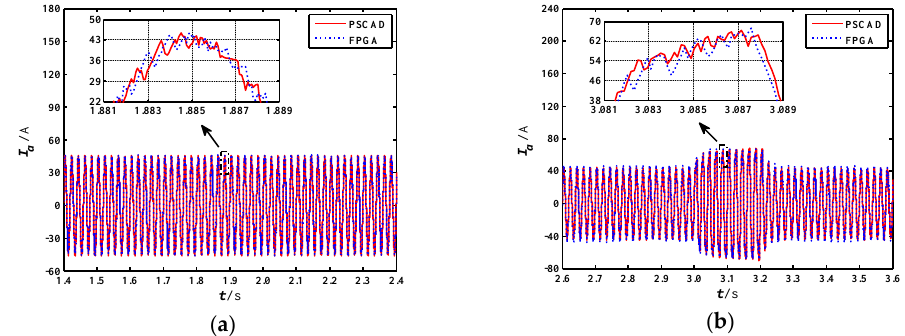
Figure 12. Comparison of the simulation results between the FPGA-based real-time simulator and PSCAD/EMTDC. ( a ) A phase current I a of the grid-connected point of the PV in Scenario 1. ( b ) A phase current I a of the grid-connected point of the PV in Scenario